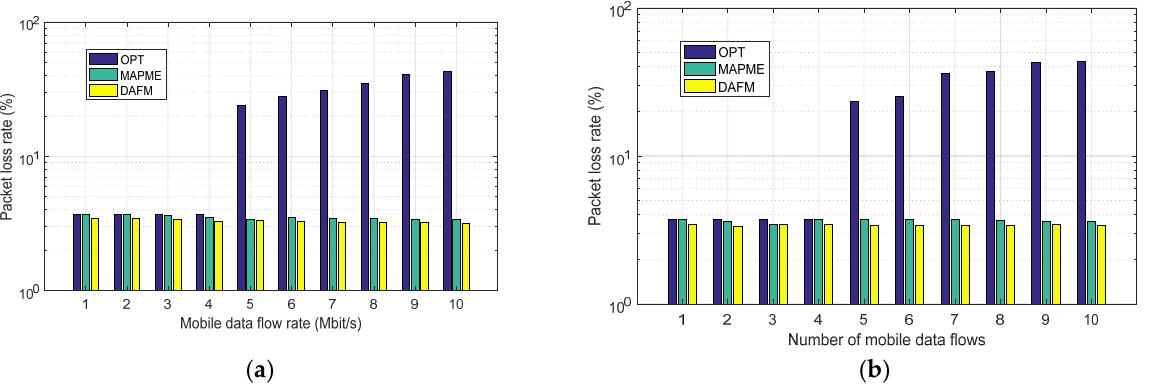
Figure 5. Comparison of packet loss rates in different scenarios. ( a ) Packet loss rate vs. mobile data flow rate; ( b ) packet loss rate vs. number of mobile data flows.